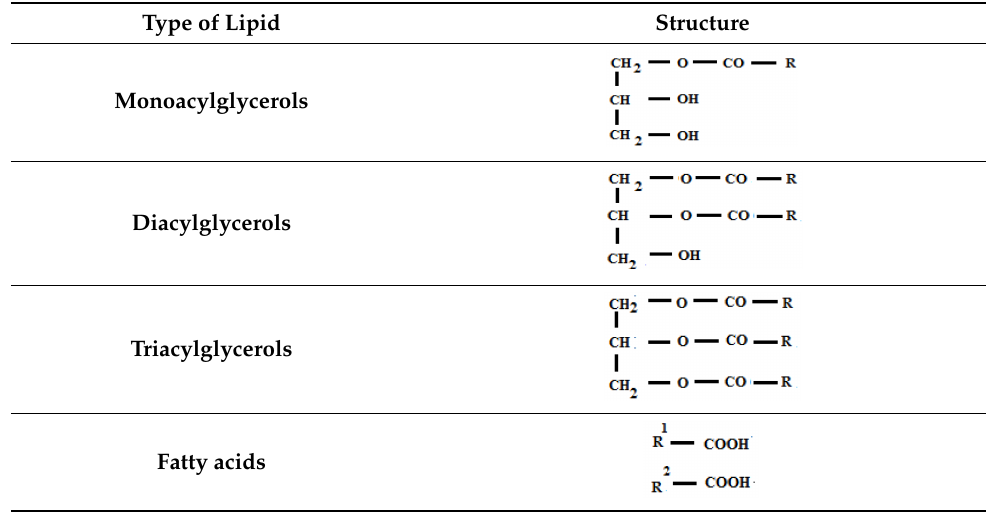
Table 4. Selected lipids used for LNP synthesis and their